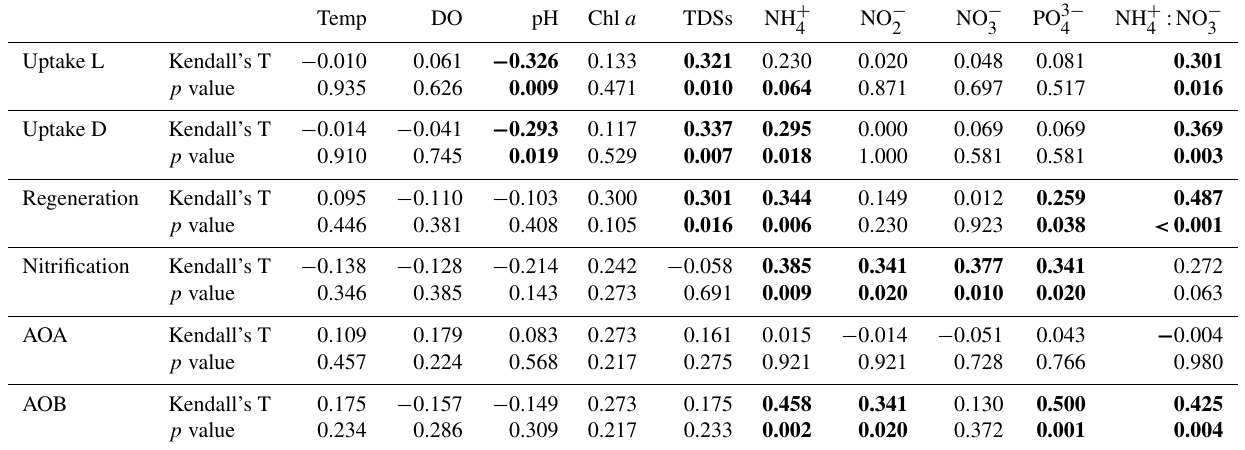
Table 2. Details of non-parametric Kendall’s correlation analysis. Statistically significant ( p < 0 . 05) Kendall’s Tau (T) coefficients are